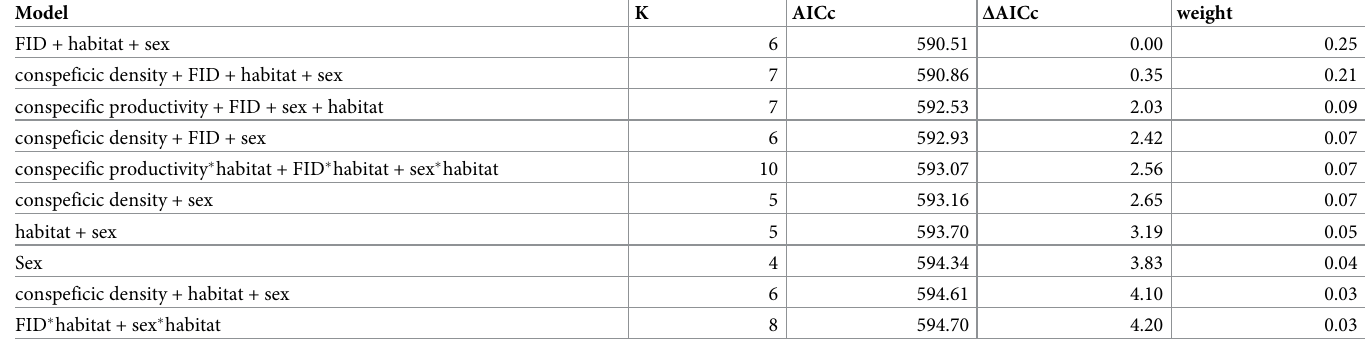
Table 1. Models obtained to assess the relative importance of individual’s traits (sex and personality, measured as FID), and social variables (conspecific density and productivity in the natal area) on the natal dispersal distances of rural and urban (habitat) burrowing owls Athene cunicularia . Models shown are the first